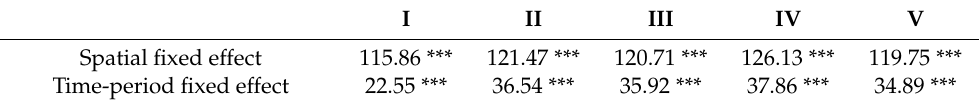
Table 4. F statistic